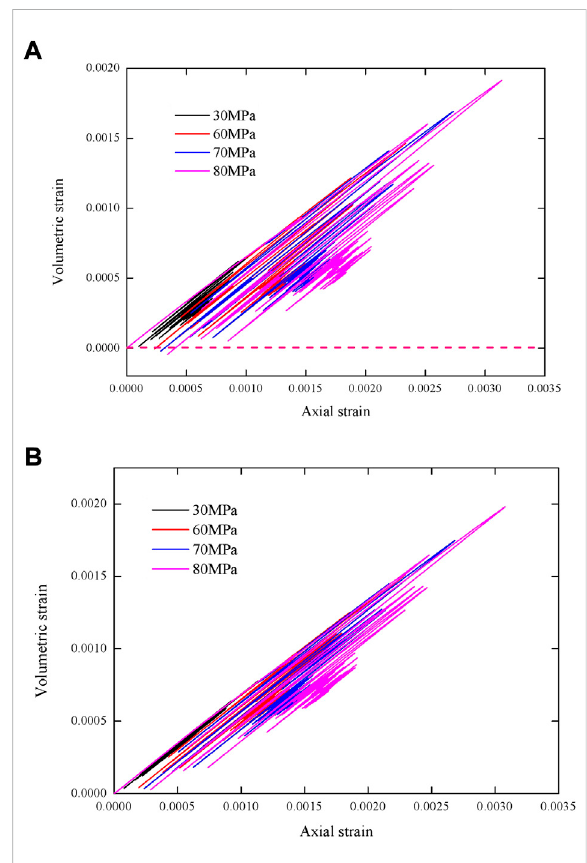
FIGURE 5 The volumetric strain-axial strain curves of the rock under Kobe seismic load with different maximum stresses: (A) Uniaxial loading; (B) Triaxial loading with con fi ning pressure of 15